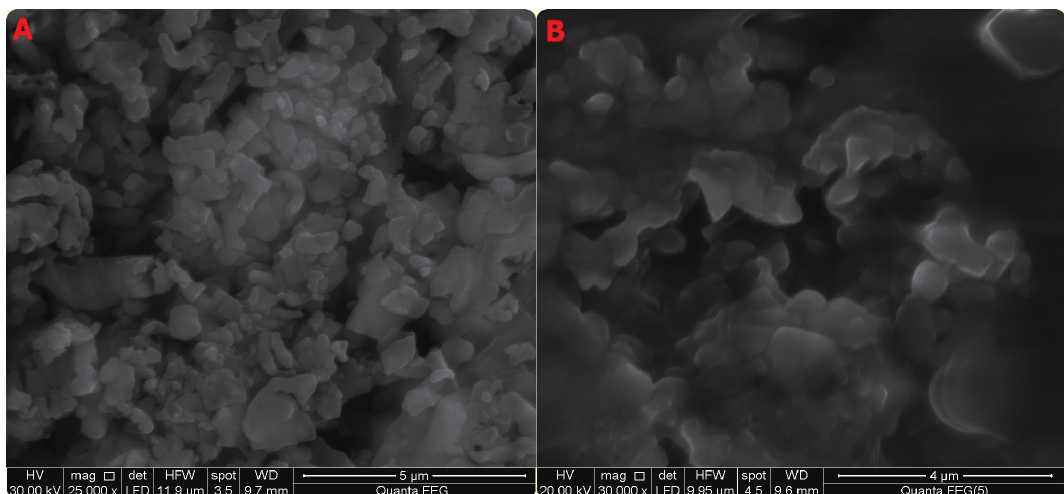
FIGURE 2 - The scanning electron microscope (SEM) images of A) A. squamosa extract-entrapped liposome and B) A. squamosa extract-entrapped niosome.